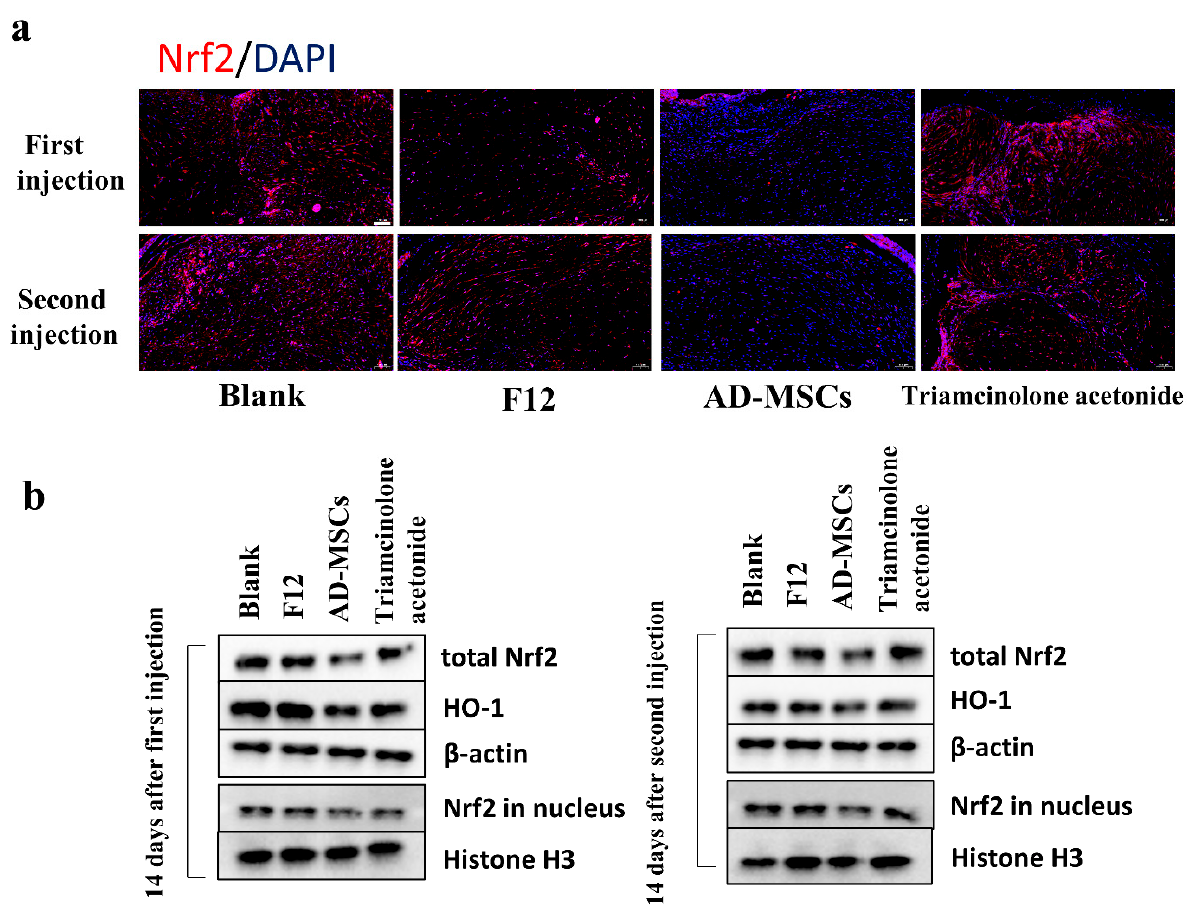
Figure 8. AD-MSCs inhibited the expression of Nrf2 and antioxidant enzymes in hypertrophic scar tissue transplanted in nude mice. ( a ) Levels of Nrf2 expression were determined through immunofluorescence in sections from transplanted tissues after the first and second injection of blank, F12, AD-MSCs, and triamcinolone acetonide groups. Scale bar = 100 µ m. ( b ) Western blot assay for expression of total Nrf2, HO-1, and Nrf2 in nucleus in hypertrophic scar tissue transplanted in nude mice of different groups.